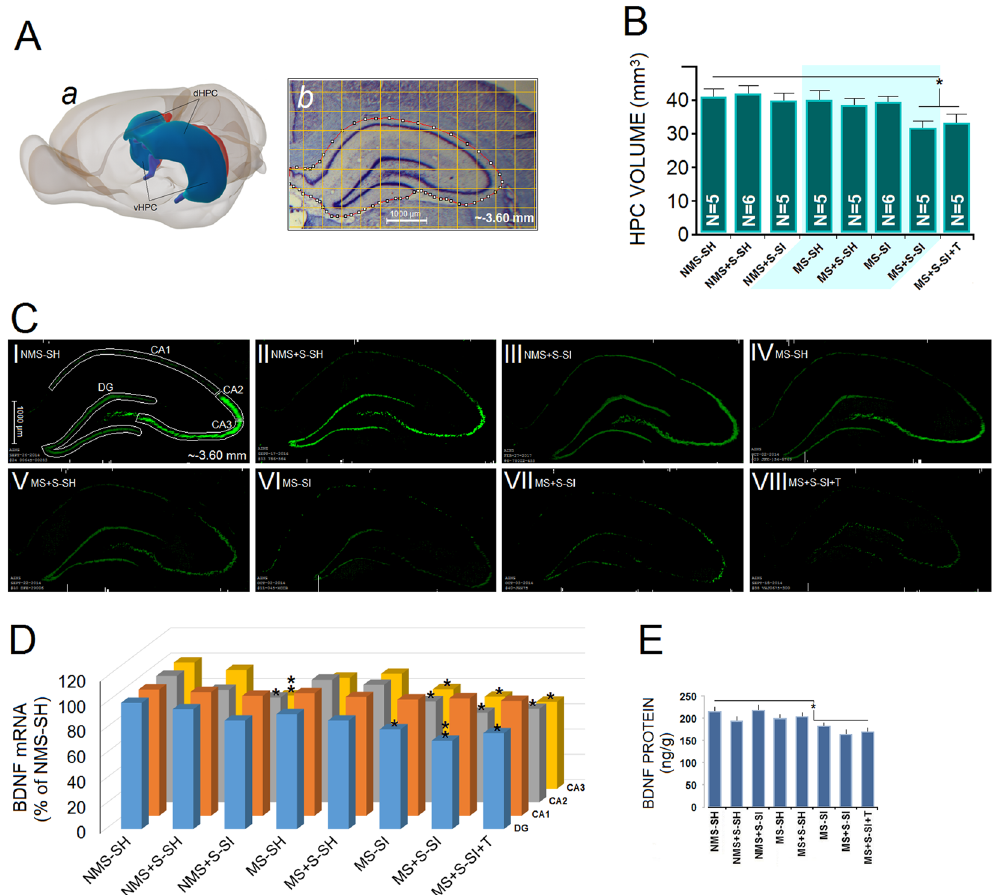
Figure 3. Combined ancestral and adulthood stress reduce hippocampal volume and BDNF expression . ( A ) A set of 10–11 cross sections of whole hippocampus (AP: − 1.4 mm − 6.80 mm) were considered for volumetric analysis. ( a ) 3D reconstruction of the dorsal and ventral hippocampus (blue) in the rat brain. ( b ) Coronal view of a left dorsal hippocampus illustrating the area that was considered for hippocampal volumetrics. ( B ) The MS + S-SI and MS + S-SI + T animals indicated decreased HPC volume when compared with other groups. ( C ) Subpanels I-VIII: The investigated anatomical subregions are delineated for NMS-SH animals. Autoradiographs (unsharp mask-HK1-RSZII2.60 filter-Green) of BDNF mRNA in the dHPC (CA1, CA2, CA3, and DG) indicated that only social isolation reduced BDNF mRNA expression in CA2, CA3 and DG in multigenerationally stressed animals. ( D ) Density of BDNF mRNA signal in CA1, CA2, CA3 and DG. BDNF mRNA data ( N = 3–4 per group) in this experiment are represented as percent of the NMS-SH group; ( E ) BDNF protein levels in dHPC. No difference was observed between right and left dHPC in terms of BDNF mRNA expression and proteins. Asterisks indicate significant differences: * p ≤ 0.05, ** p ≤ 0.01; ANOVA. Error bars show ±